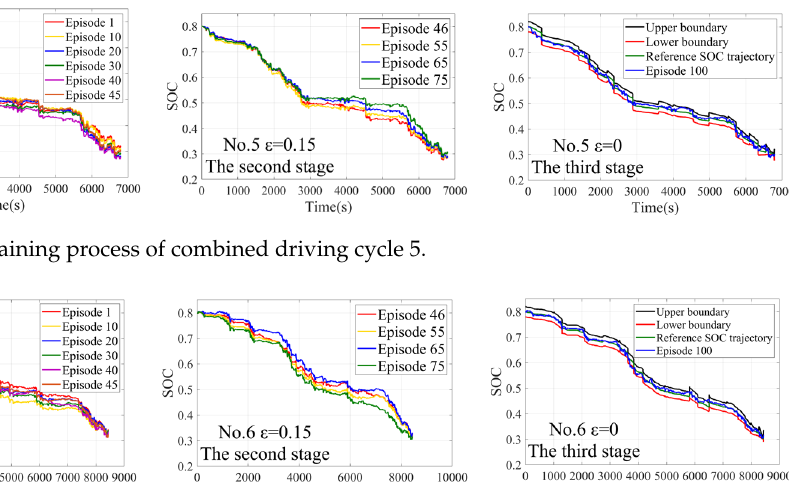
Figure 15. The training process of combined driving cycle 6.